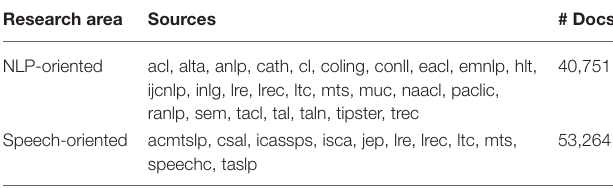
TABLE 2 | Sources attached to each of the two research